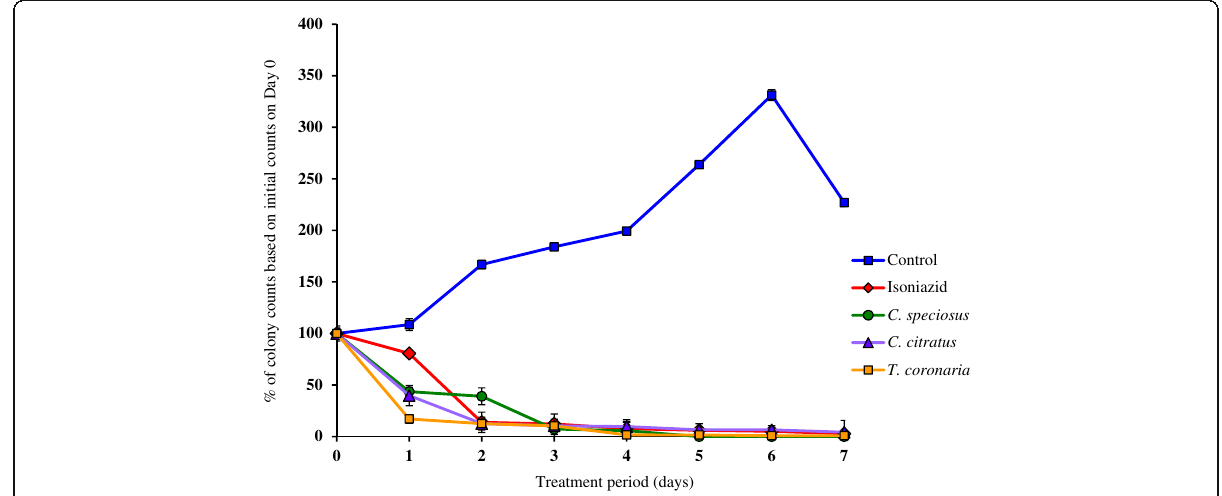
Fig. 3 Effects of n-hexane plant partitions on the growth kinetics of Mycobacterium tuberculosis H37Rv over 7-day treatment